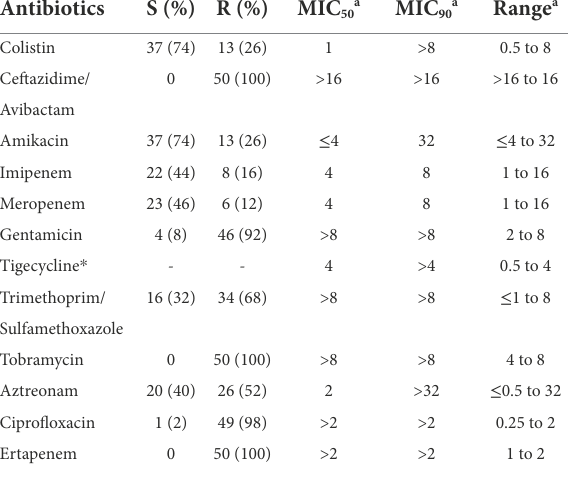
TABLE 3 Antibiotic susceptibility of 50 IMP-producing Enterobacterales as determined by the microdilution method according to EUCAST clinical